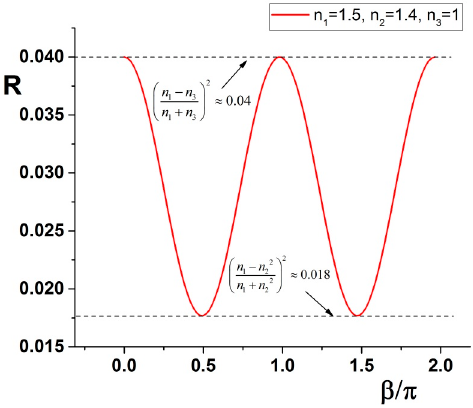
Figure 1. The reflectance R is plotted following Equation (18) having n 1 = 1.5, n 2 = 1.4, n 3 = 1. The amplitude oscillates between the extremes described in Equation (19).